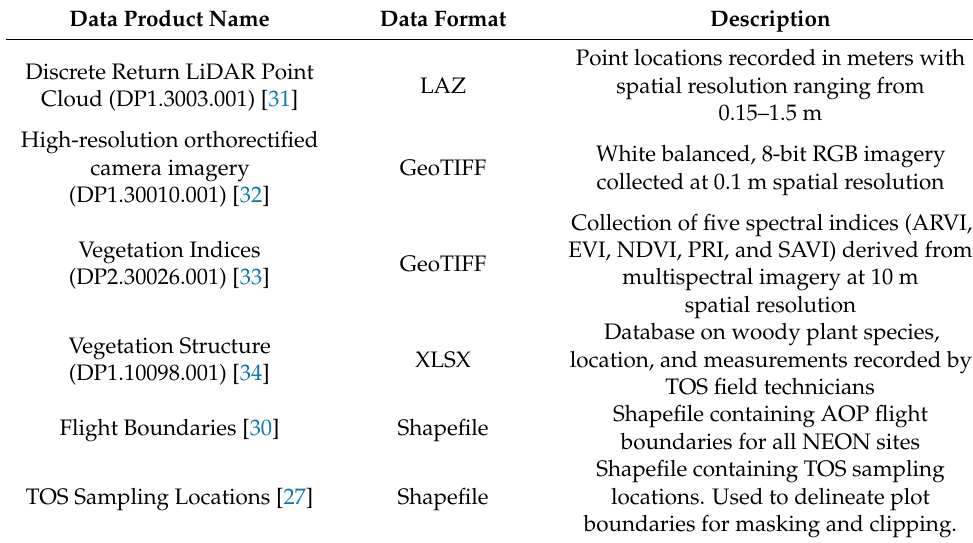
Table 1. Data products downloaded from the NEON Data Portal. DP1 and DP2 indicate Level-1 and Level-2 data products,